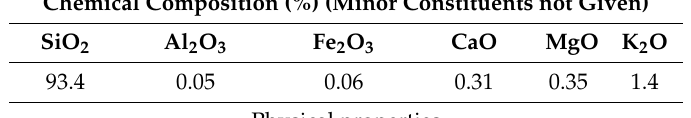
Table 4. Typical chemical and physical properties of rice husk ash [44,45].